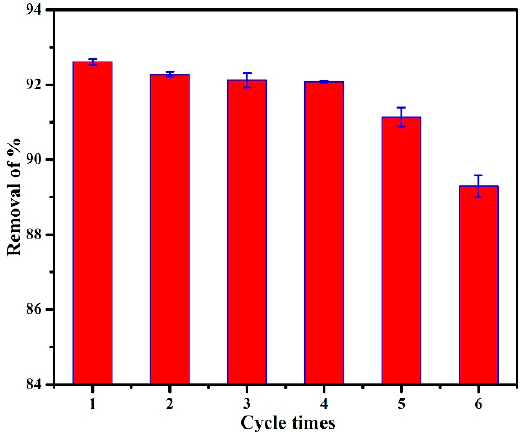
Figure 9. Removal efficiency of the PANI/PSMA in six successive cycles of desorption–adsorption. Figure 9. Removal e ffi ciency of the PANI / PSMA in six successive cycles of desorption–adsorption.